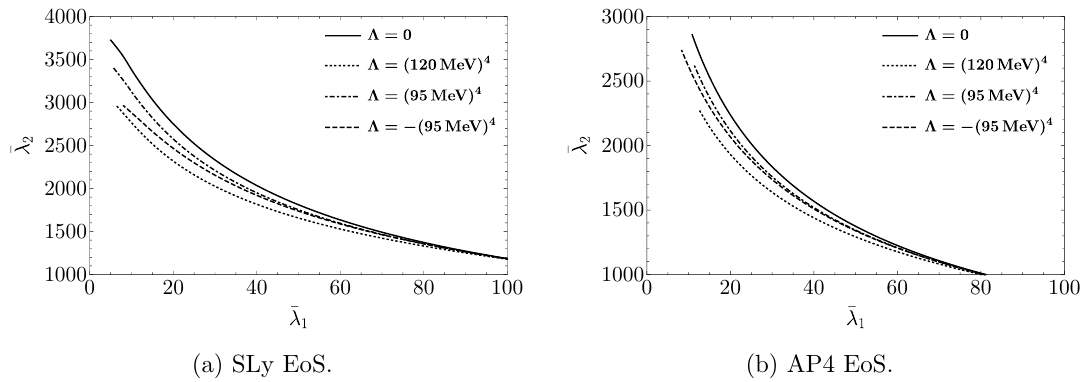
Figure 5. Tidal deformability curves for a neutron star binary with SLy and AP4 EoS’s. The chirp mass is taken to be M = 1 : 188 M (cid:12) , which is the same value as in GW170817. (cid:22) (cid:21) 1 and (cid:22) (cid:21) 2 correspond to the dimensionless tidal deformability parameters for the heavy and light stars, respectively. Each curve is obtained by varying the heavy star mass while holding the chirp mass (cid:12)xed. The (cid:11) -parameter of (2.14) is chosen to be (cid:11) = 3.